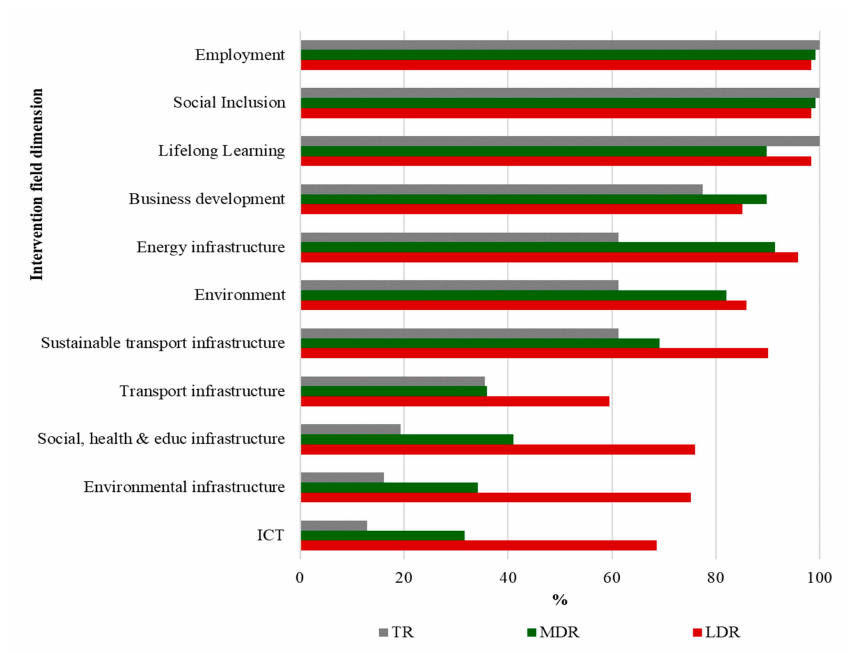
Figure 4. Percentage of NUTS 2 regions with allocated investment in each intervention field dimension, by category of region. Note: Numbers are calculated as a percentage of the number of regions within each category of region (LD, transition region (TR), and